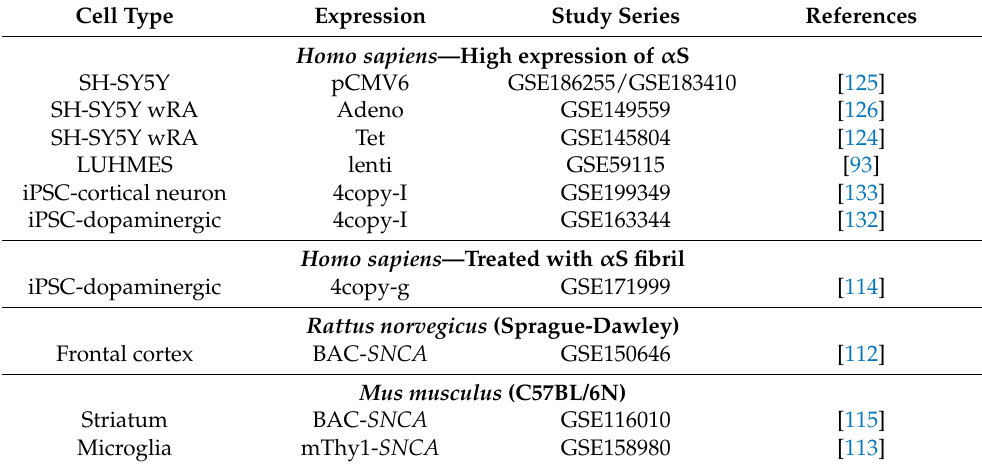
Table 1. Publicly available RNA sequencing datasets of cell or animal models expressing SNCA or exposure to α S